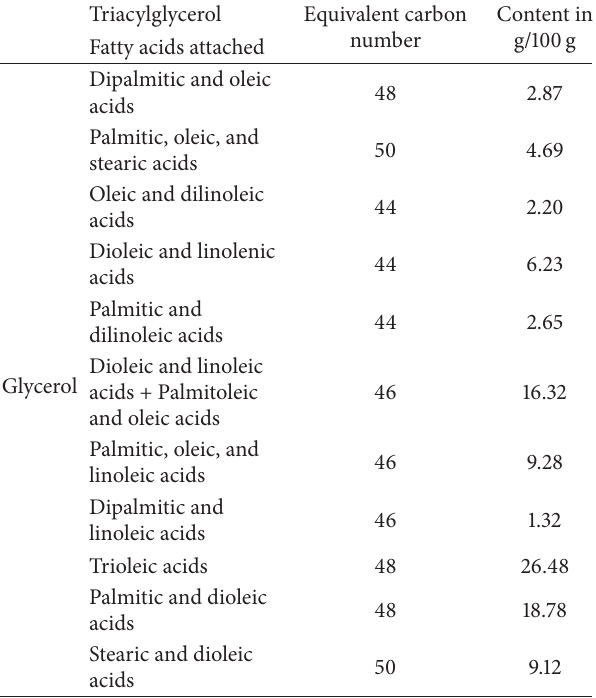
(Table 7). In Z. lotus seed, total proteins represent 14.22% higher than Z. lotus pulp with 1.18% [19]. But nowadays, amino composition of Z. lotus pulp remains to be